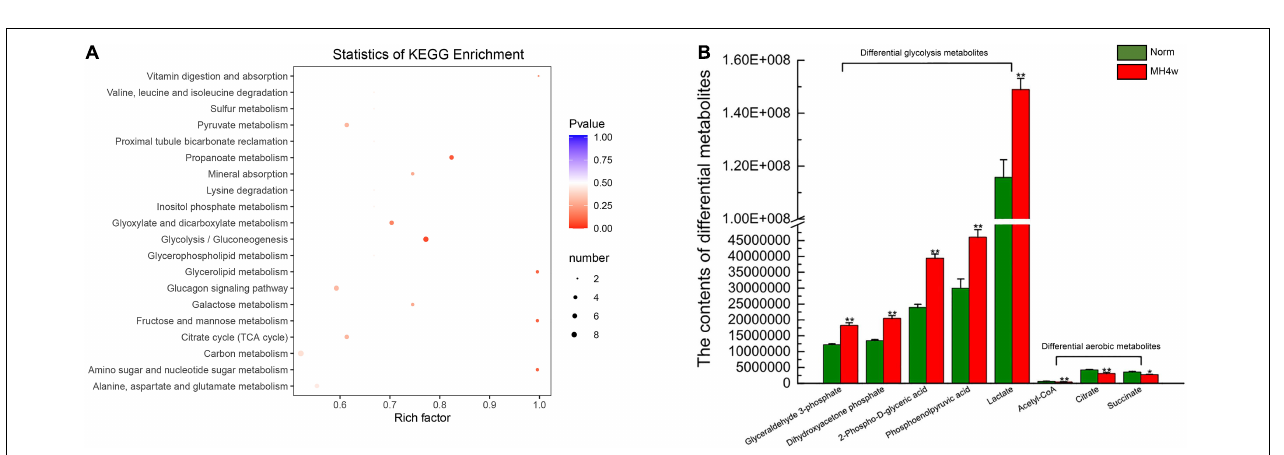
FIGURE 5 | The KEGG functional pathway information based on Bacteroidales -related bin 118 (A) , Clostridum -related bin 33 (B) , and Desulfovibrio -related bin 318 (C) .